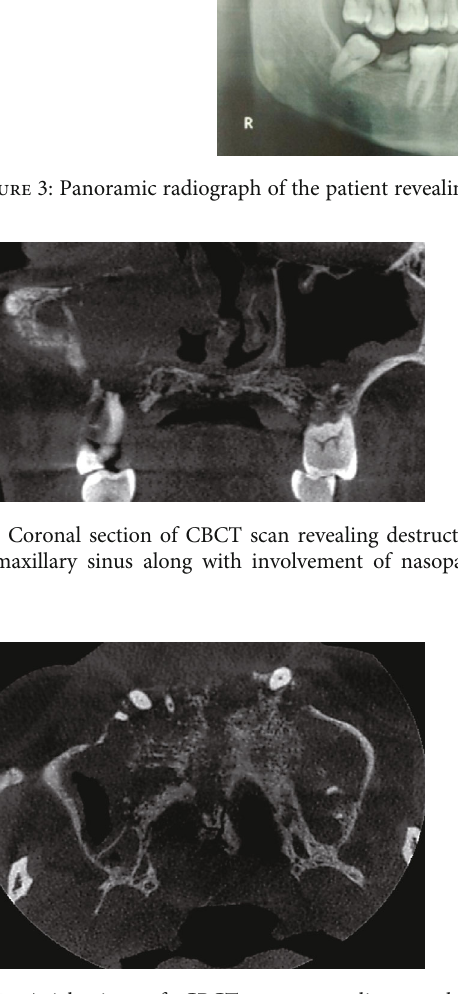
Figure 5: Axial view of CBCT scan revealing moth-eaten appearance of maxilla involving the hard palate and maxillary bone.